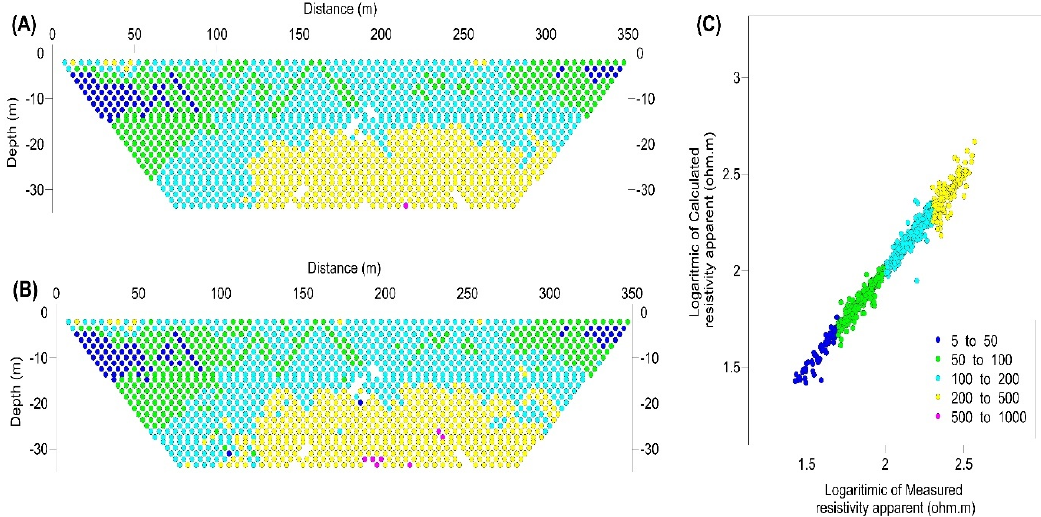
Figure 4. ( A ) Observed and ( B ) measured apparent resistivity along profile APA02. ( C ) The logarithm of the apparent vs. calculated values of